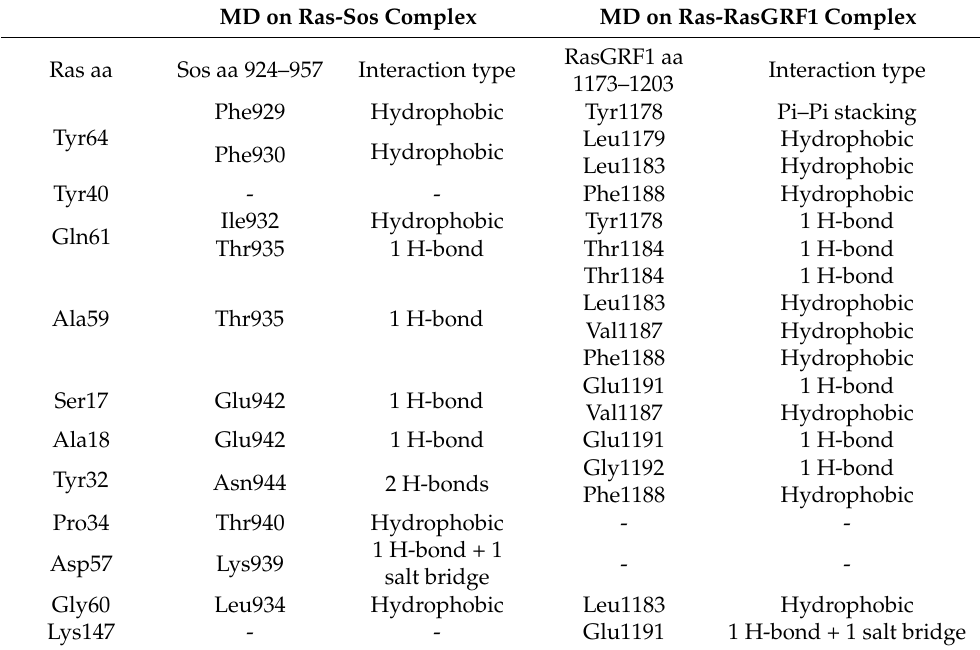
Table 3. Stable interactions established during MD trajectories of Ras-Sos and Ras-RasGRF1